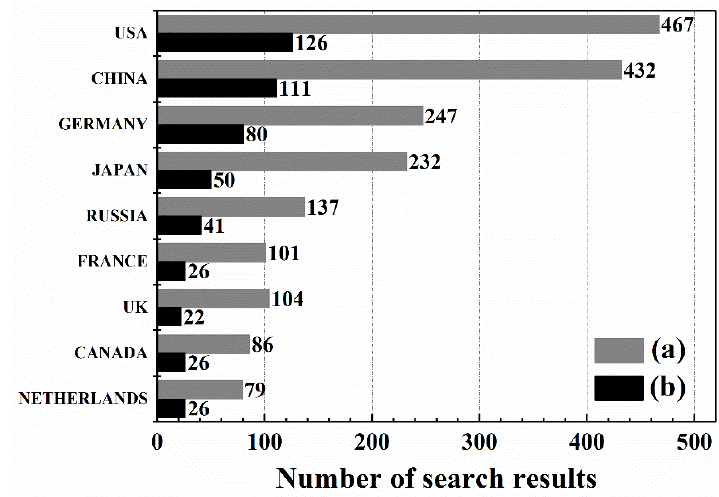
Figure 3. Geographical distributions of search results using the keyword sets (a): oxidative, methane and coupling; and (b): oxidative, methane, coupling and ethylene. Plotted countries represent 73 and 66% of the total number of search results for keyword sets (a) and (b), respectively.